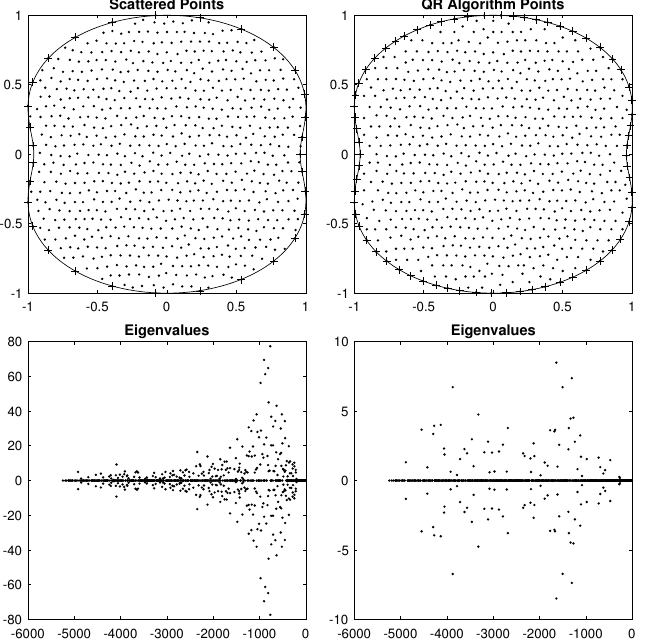
Figure 19. MCpQR boundary selection for scattered repel algorithm points on the peanut